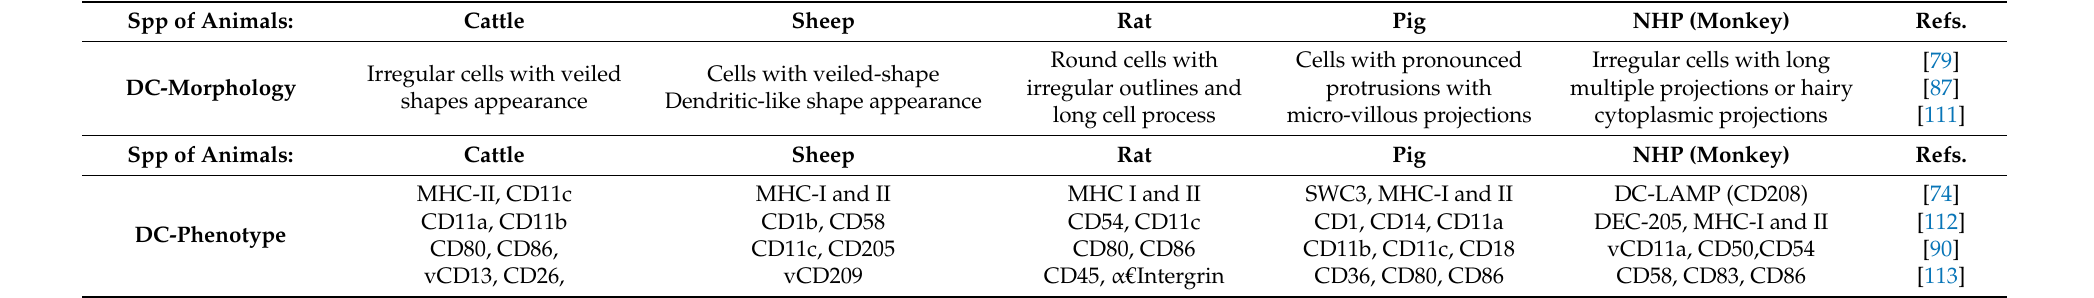
Table 3. Dendritic cell (DC) morphology and phenotype in different species of